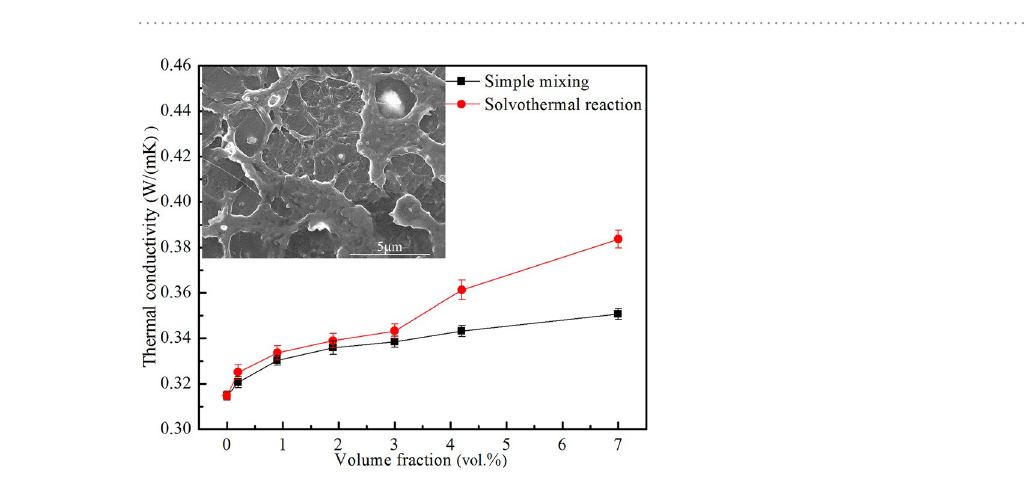
Figure 2. Comparison of thermal conductivity of Fe 3 O 4 /LDPE composites prepared by simple mixing method and solvothermal reaction. The inset shows the cross-sectional SEM images of the Fe 3 O 4 /LDPE composites at 7 vol.% concentration prepared by simple mixing